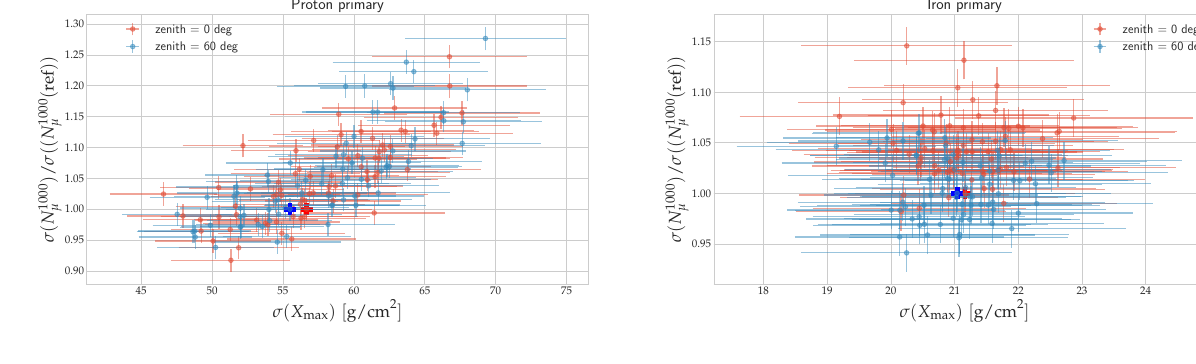
Figure 3. Results of simulations in [ σ ( X max ),